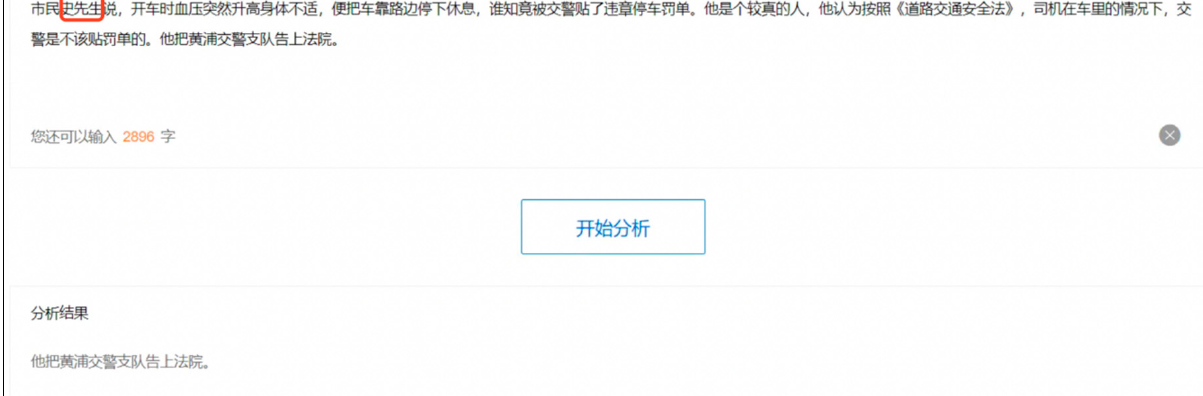
Figure 1. Example 1 of Baidu online text summarization results (input: Mr. Shi, a citizen, said that when he was driving, his blood pressure suddenly became high and his body was unwell, so he stopped his car by the roadside to have a rest. Unexpectedly, he was posted a parking ticket by the traffic police. He is a serious person. He believes that according to the road traffic safety law, the traffic police should not stick a ticket when the driver is in the car. He took the Huangpu traffic police detachment to court. Output: He took the Huangpu traffic police detachment to court.).